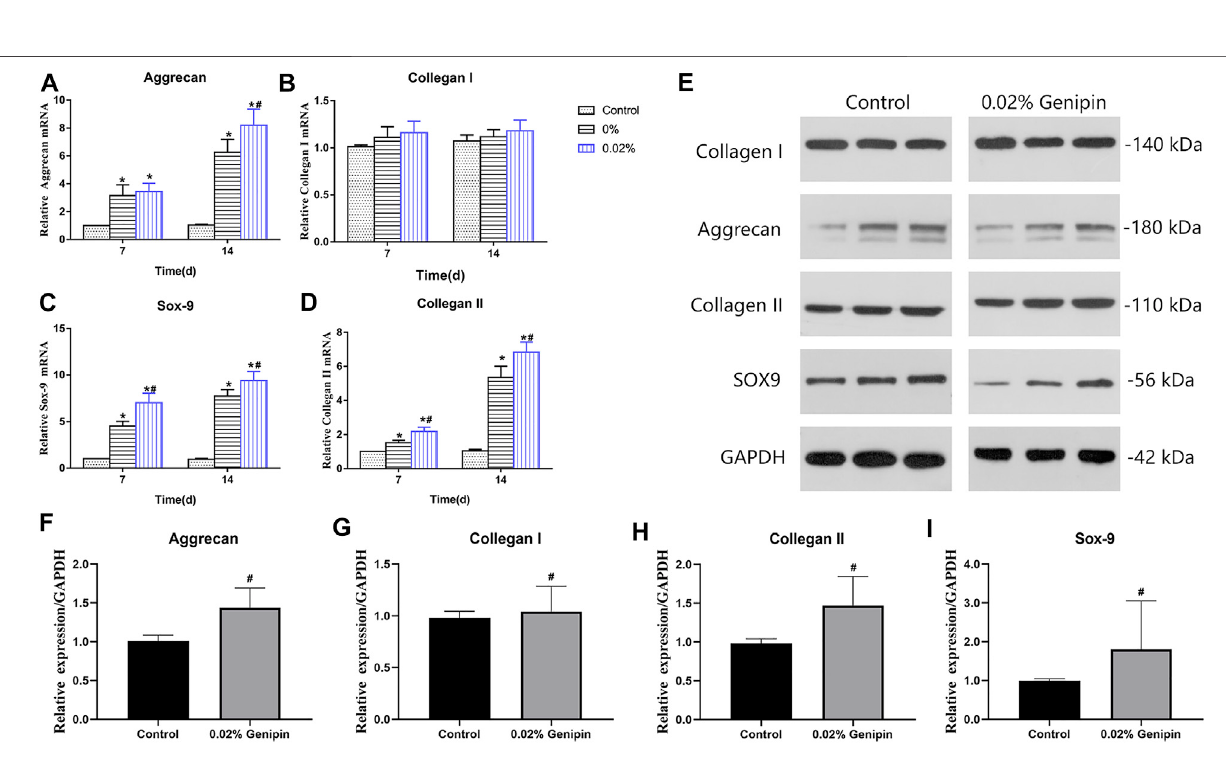
FIGURE5| Nucleuspulposus-relatedgeneexpressionlevelsofADSCs.GeneexpressionlevelsofAcan (A) ,Col-I (B) ,Sox9 (C) ,andCol-II (D) weremeasuredat7 and 14 days. Veri fi cation of Western blot for NP-related gene expression at 7 days is shown in (E – I) . Data represented mean ± SD ( n (cid:2) 5); * p < 0.05, vs. 0% group; # p < 0.05, vs. 0.2%